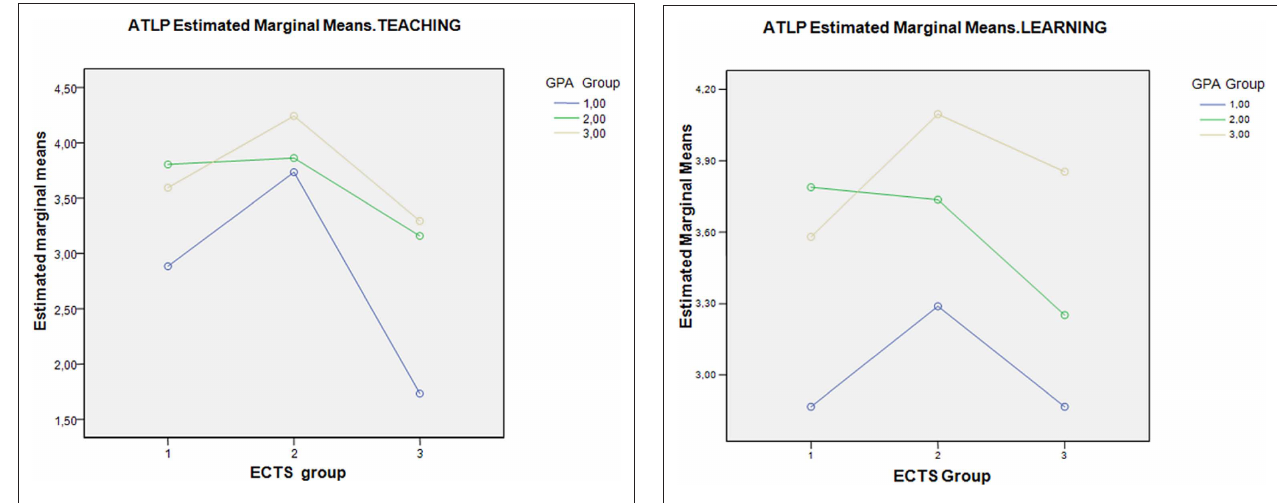
FIguRE 7 | Perception of the learning process, according to performance level and subject credit